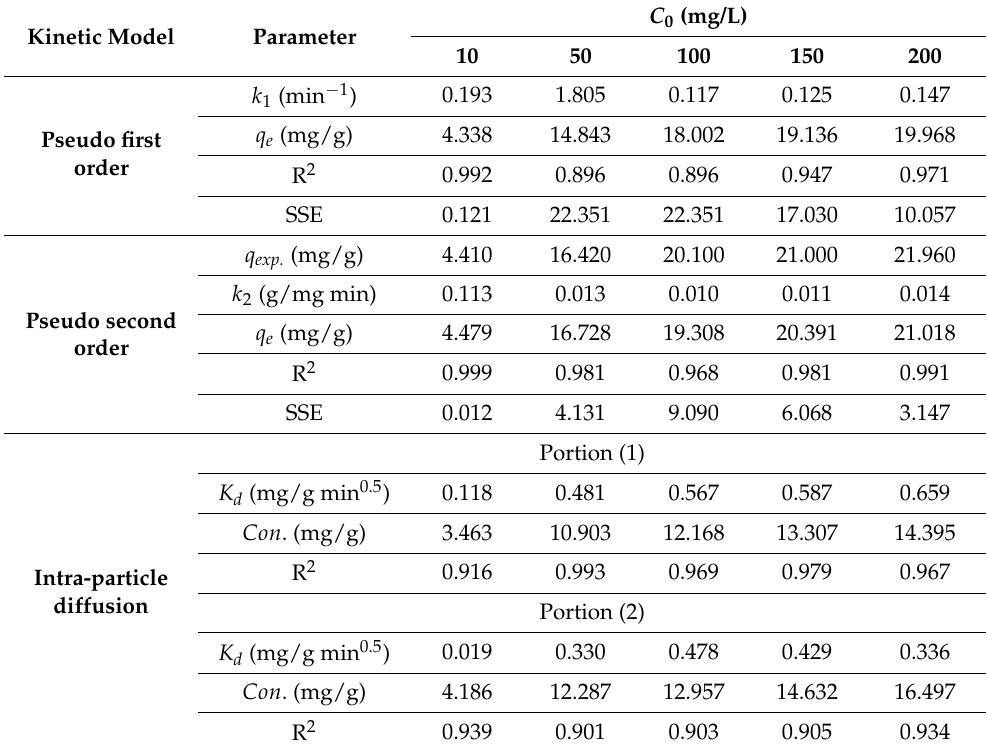
Table 3. Kinetics parameters for tetracycline adsorbed by sand coated with calcium ferric oxides. Kinetic